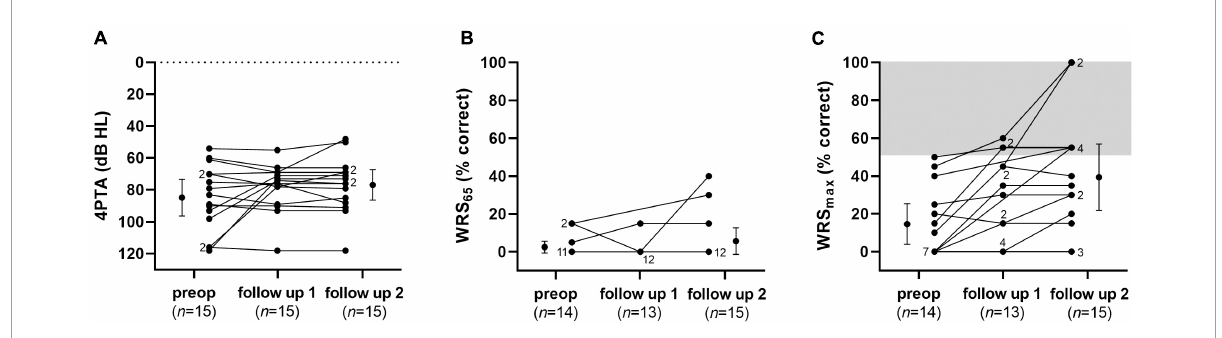
FIGURE9 Audiological results: Pure-tone thresholds (A) , word recognition scores at 65 dB SPL (B) and maximum word recognition scores (C) preoperatively, 8–12 weeks, and 9–12 months after implantation of the drug delivery system with controlled release of dexamethasone into the RW niche as individual values and means (preoperative and follow-up 2). Error bars show the 95% confidence interval. Numbers indicate the amount of superposed data points.